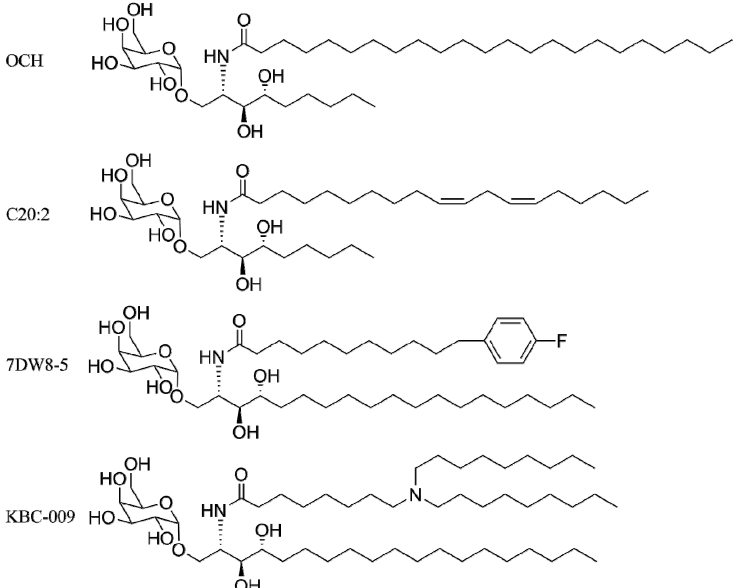
Figure 4. iNKT cell antigens with varied lipid